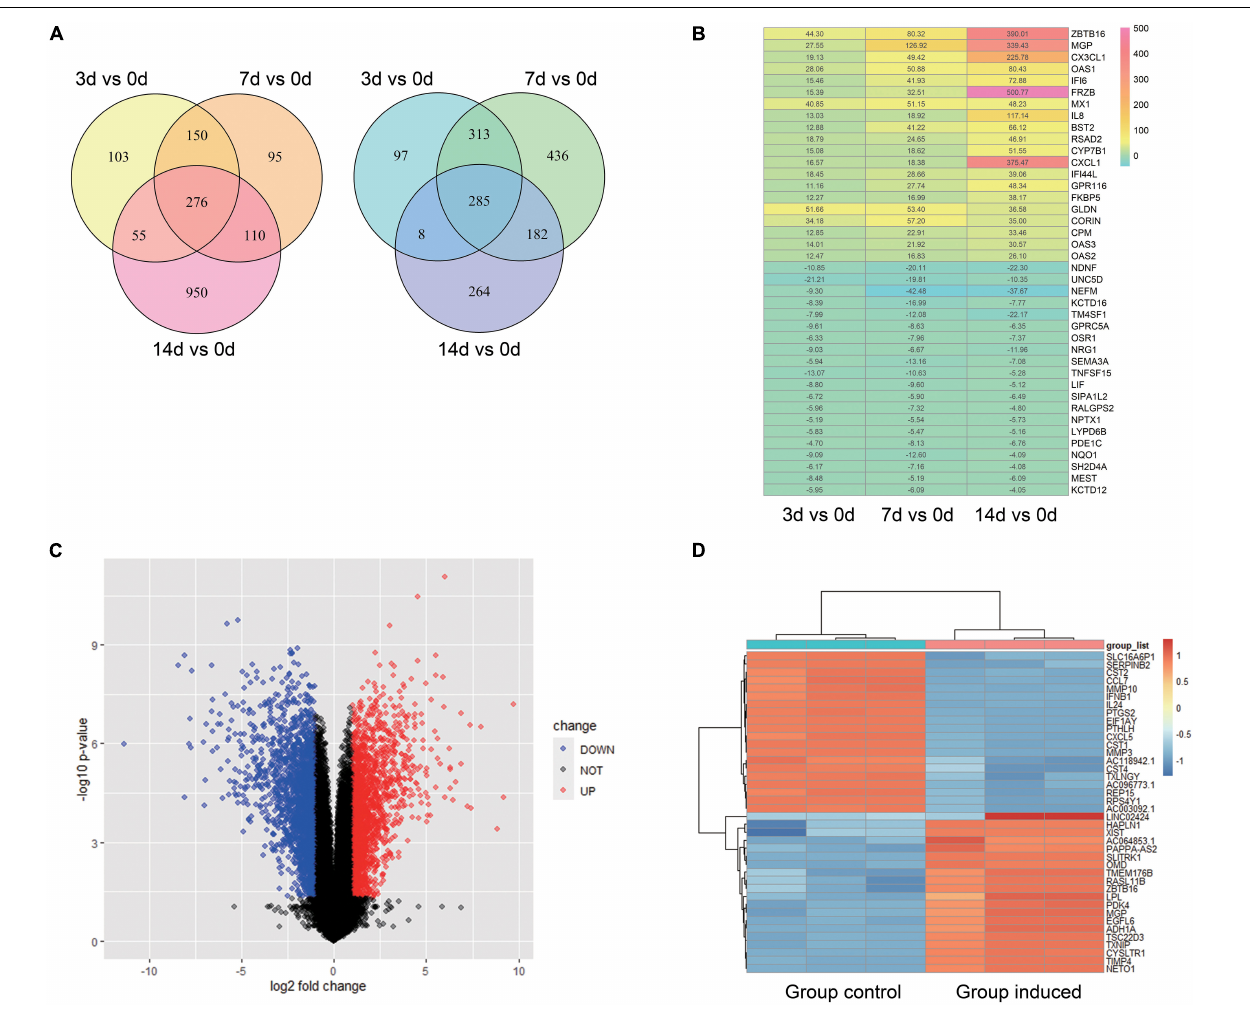
FIGURE 1 | Analysis of differentially expressed genes (DEGs) of GSE99958 and GSE159507. For GSE99958, the CONORS package was used to analyze the differentially expressed genes (DEGs) between the Group induced 3, 7, 14 days and the Group control. A venn graph (A) shows the total 276 up-regulated and 285 down-regulated DEGs and a heat map (B) shows representative DEGs. The number in the heat map grid represents multiples of gene counts. For GSE159507, the limma package was used to analyze the difference genes between the Group induced and the Group control. A volcano plot (C) and heat map (D) reveal the 4,082 DEGs (total 1,908 up-regulated and 2,174 down-regulated DEGs). Red color indicates up-regulated genes, and blue indicates down-regulated genes. Group Control: PDLSCs treated with control medium. Group induced: PDLSCs treated with osteogenic medium.